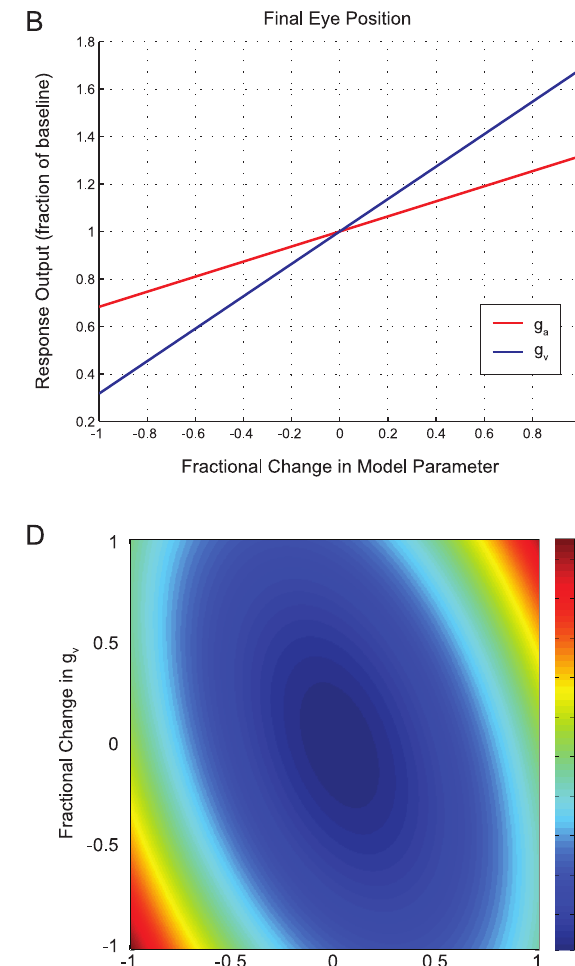
Figure 4. Simulink model optimizations. a . Results from M1 for leftward translation in darkness at each distance before and after Nod/Uv lesions. Leftward head velocity for one trial is shown in green. The blue trace represents the median rightward slow-phase eye velocity (saccades excluded) for all trials. The red trace is the simulated eye velocity using the parameter values determined by the optimization procedure. Note that each optimization used the whole series of trials, not the median eye velocity. b . Optimized values for integrator gain (G i ) and acceleration gain (G acc ) before (blue) and after (red) the Nod/Uv lesions, by animal (M1, M2), viewing distance in cm (27, 70), and direction of motion (R, L).